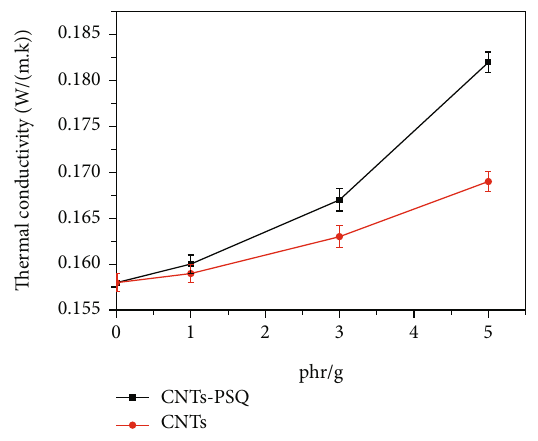
Figure 7: Thermal conductivity versus CNTs-PSQ and CNTs nanoparticle content for the